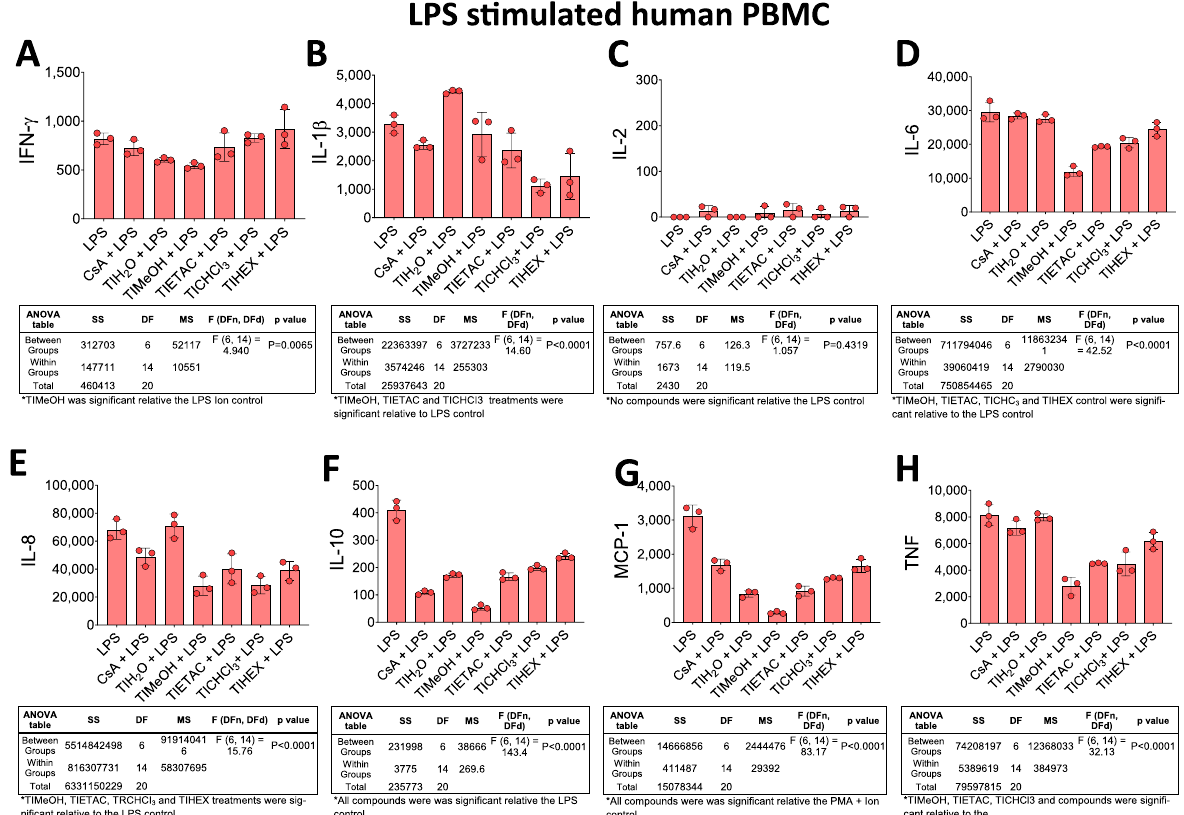
Figure 5. Handroanthus impetiginosus (Mart. ex DC.) Mattos (Bignoniaceae) bark-derived compounds can suppress cytokine release of LPS-activated PBMC. PBMC were combined with TIH 2 O aqueous extracts, TIMeOH methanolic extracts, TIETAC ethyl acetate extracts, TICHCl 3 chloroform extracts and TIHEX hexane extracts for 24 h. Individual cytokine levels of ( A ) IFN-γ, ( B ) IL-1β, ( C ) IL-2, ( D ) IL-6, ( E ) IL-8, ( F ) IL-10, ( G ) MCP-1 and ( H ) TNF were quantified by CBA as detailed in the Material and Methods. The data is the mean of three replicates ± SD. Associated ANOVA Tables are presented beneath the line graphs and significant or nonsignificant (*) results are shown beneath the